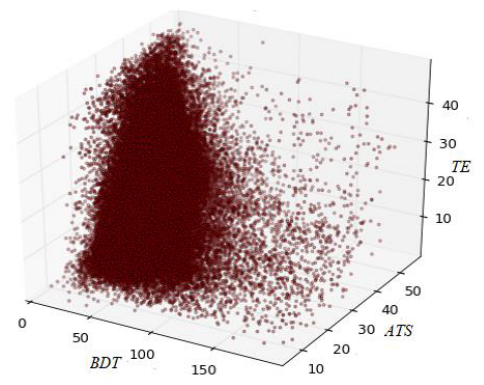
Figure 5. Distribution of the three traffic indicators of RSBs.